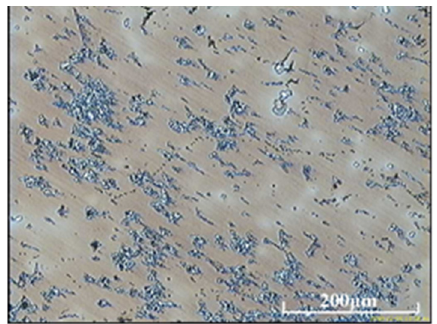
Figure 8. Sample microstructure of alloy with the addition of 4.5% Nb after solution heat treatment; austenitic matrix with niobium carbides, Nital etching.